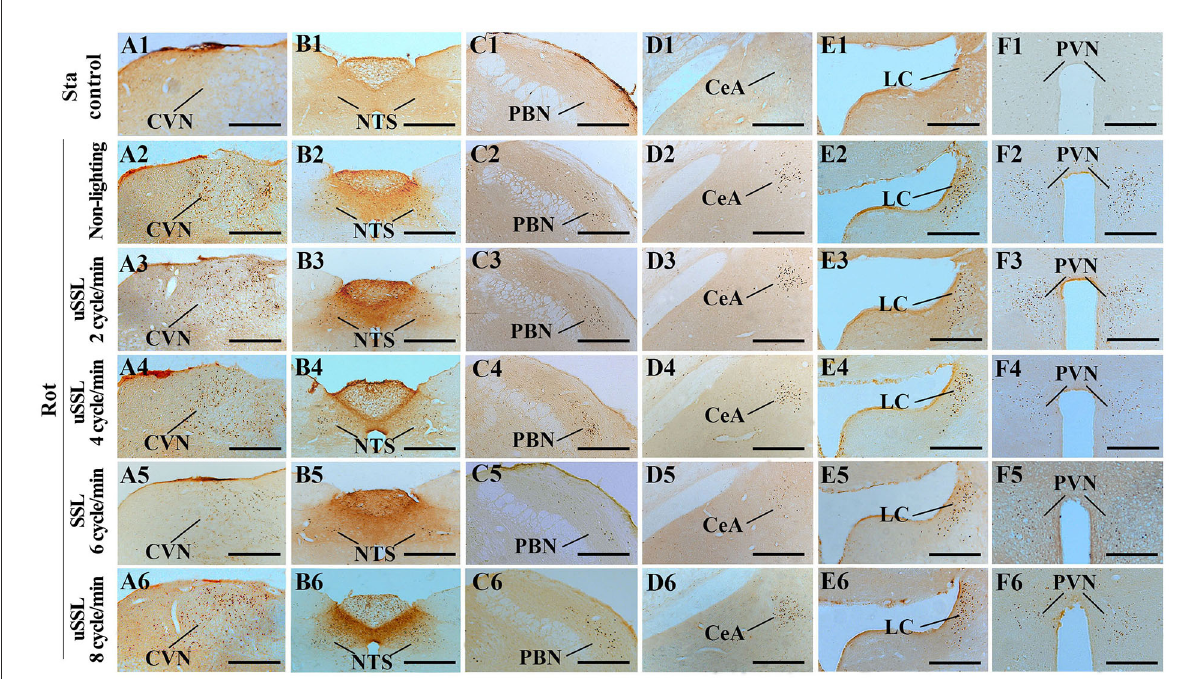
FIGURE7 Representative photomicrographs showing Fos immunolabeling in the vestibulo-autonomic and stress-related areas in rats receiving synchronized or unsynchronized stroboscopic lighting at 100Lm during rotation. Fos-labeling was presented in the caudal vestibular nucleus [CVN, (A1–A6) ], the nucleus of solitary tract [NTS, (B1–B6) ], the parabrachial nucleus [PBN, (C1–C6) ], the central amygdala [CeA, (D1–D6) ], the locus ceruleus [LC, (E1–E6) ], and the paraventricular nucleus of hypothalamus [(PVN, (F1–F6) ]. Rot, rotation stimulation; Sta, static control treatment; scale bars = 500 µ